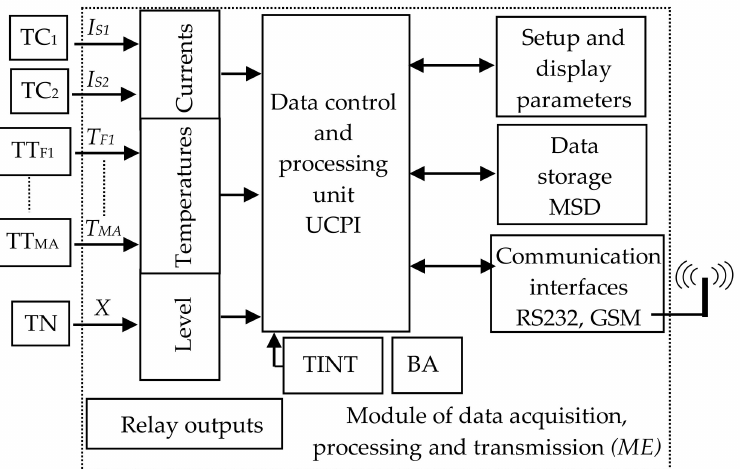
Figure 5. Block diagram of the monitoring device of the return circuit from the electric traction power supply